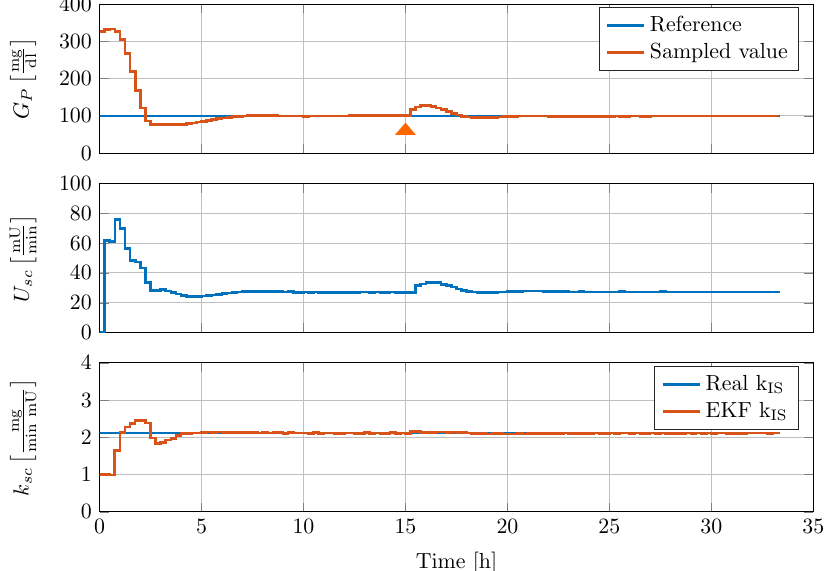
Figure 9. Controller disturbance rejection test with nonlinear minipig model #2. 50 g CHO are given to the minipig at 15 h, indicated by an orange triangle.